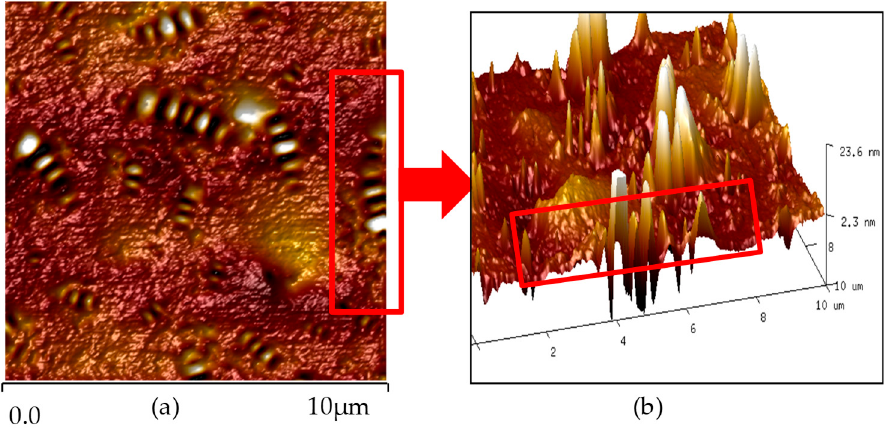
Figure 5. Bee-like structure image. ( a ) the interception point of the bee structure; ( b ) the three-dimensional height image corresponding to the interception point.